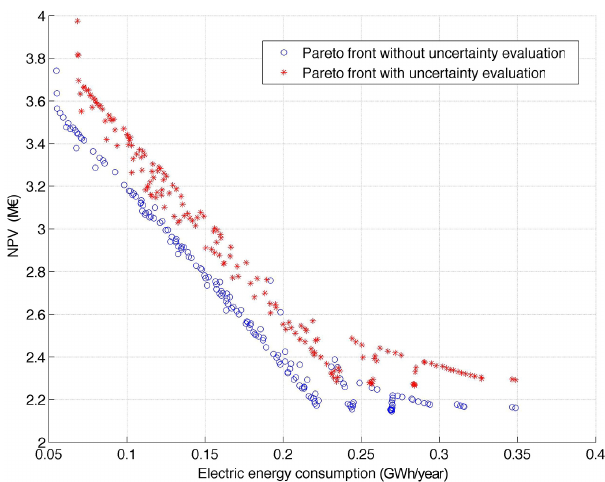
Figure 5. Uncertainty evaluation.